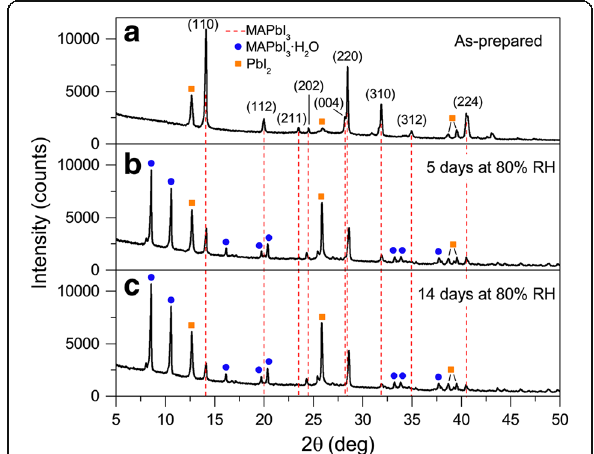
Fig. 4 X-ray diffraction pattern evolution of MAPbI 3 MWs after humidity exposure. a As-prepared sample, b after 5 days at 80% RH and c after 14 days at 80% RH. The red dash lines connecting peaks along the three patterns represent the main perovskite reflections for the tetragonal